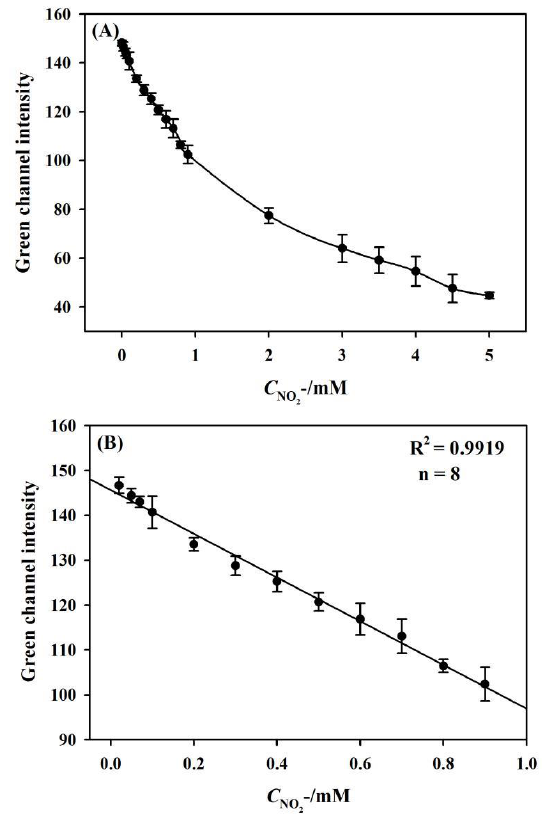
Figure 6. ( A ) Dependence of Green channel intensity on nitrite concentration. The concentrations are 0, 0.02, 0.05, 0.07, 0.1, 0.2, 0.3, 0.4, 0.5, 0.6, 0.7, 0.8, 0.9, 2.0, 3.0, 3.5, 4.0, 4.5, and 5.0 mM. ( B ) Calibrated range for nitrite detection. Table 1. Comparison of the parameters achieved for nitrite assay performed on sensors found in literature.